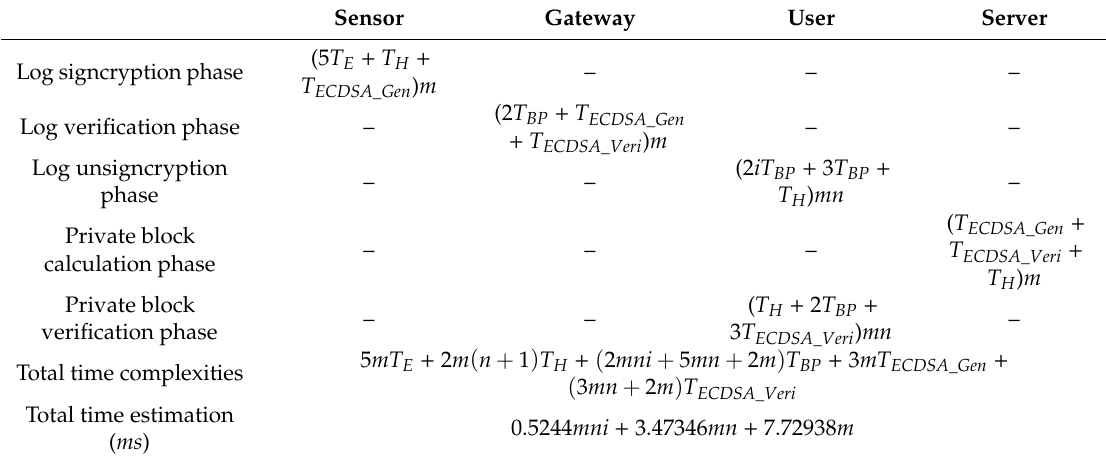
Table 5. Execution time complexities of the proposed protocol.